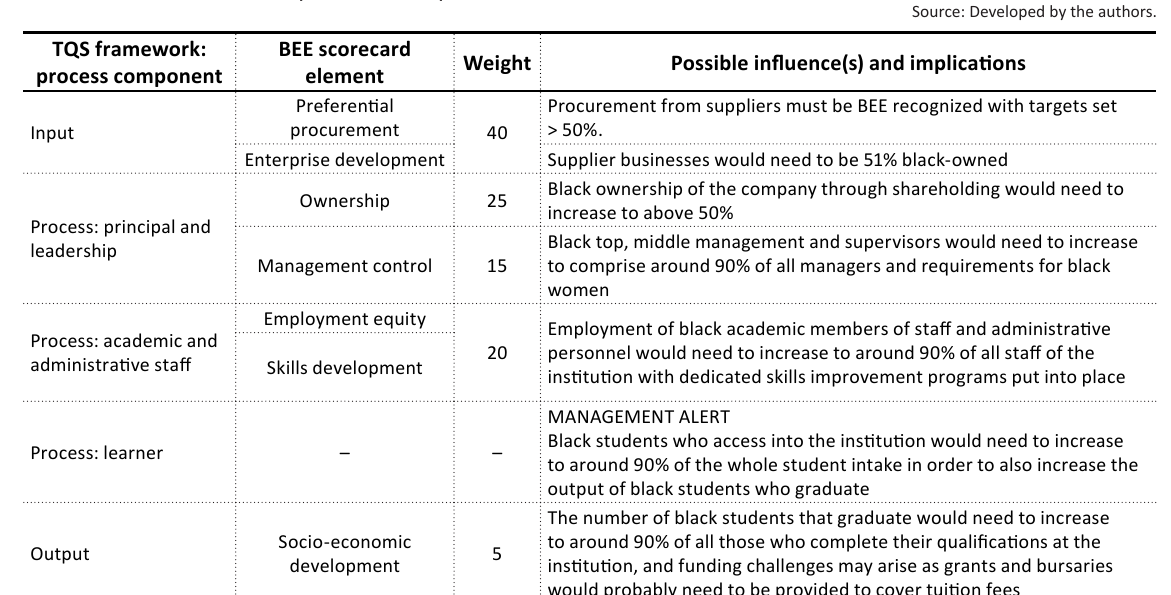
Table 4. TQS framework process component with BEE scorecard